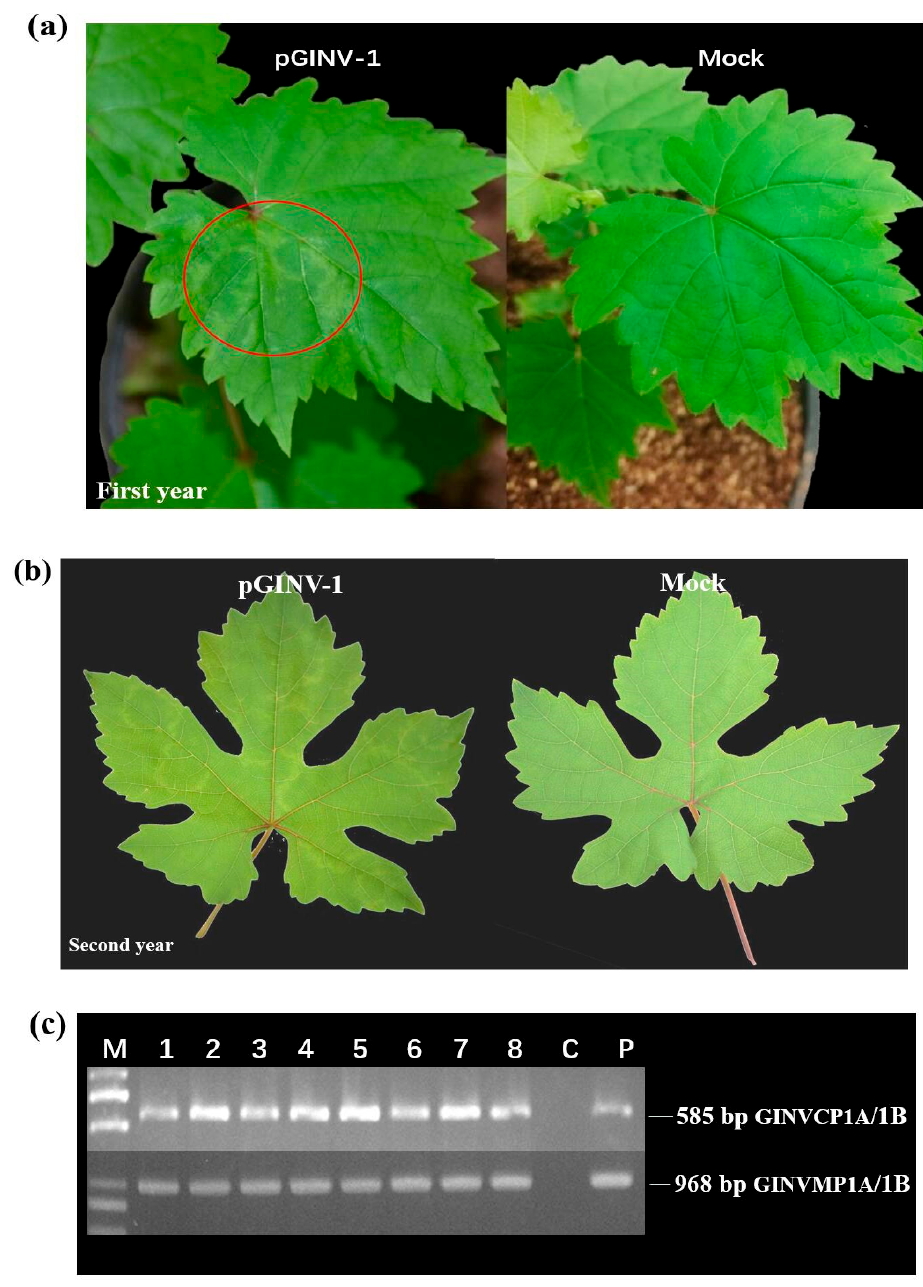
Figure 4. Infectivity test of pGIN1 in “Thompson Seedless” grapevines. ( a ) Agroinoculated “Thompson Seedless” and control grapevines three months after agroinoculation, Mock, infiltrated with agrobacterial cells containing the empty pXT1 vector; ( b ) Agroinoculated ”Thompson Seedless” and control grapevines two years after agroinoculation; ( c ) RT-PCR detection of GINV in inoculated ”Thompson Seedless” grapevines using two GINV primer pairs. M, DL2000 (TaKaRa, Dalian, China), P, positive control and C, negative control;